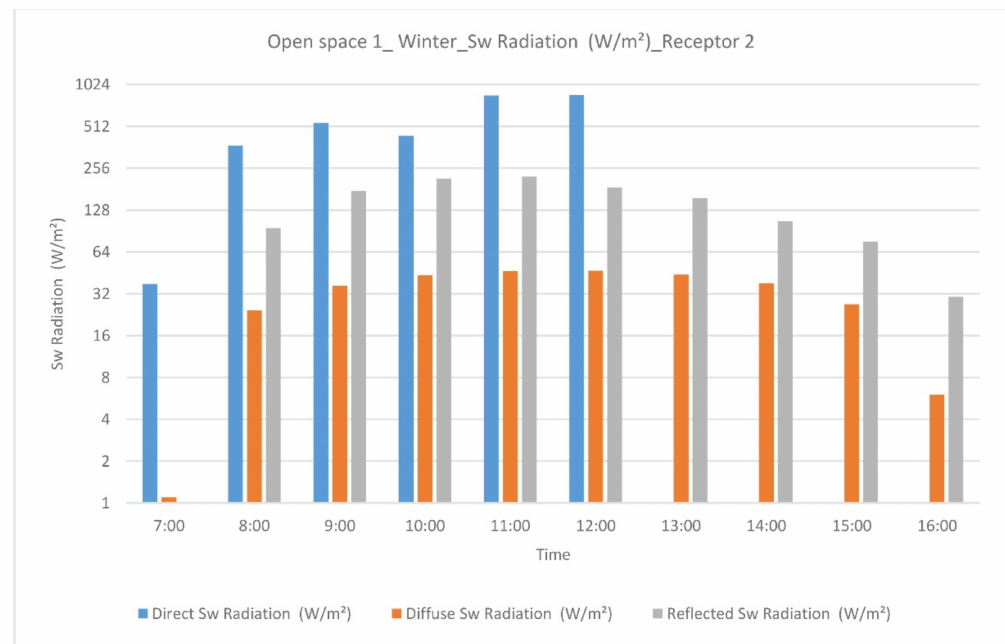
Figure A3. Open space 1 solar radiation in winter at receptor 2.